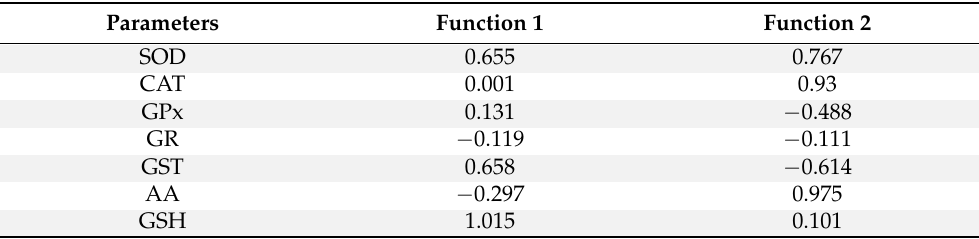
Table 4. Standardized Canonical Discriminant Function Coefficients with respect to different antioxi- dant